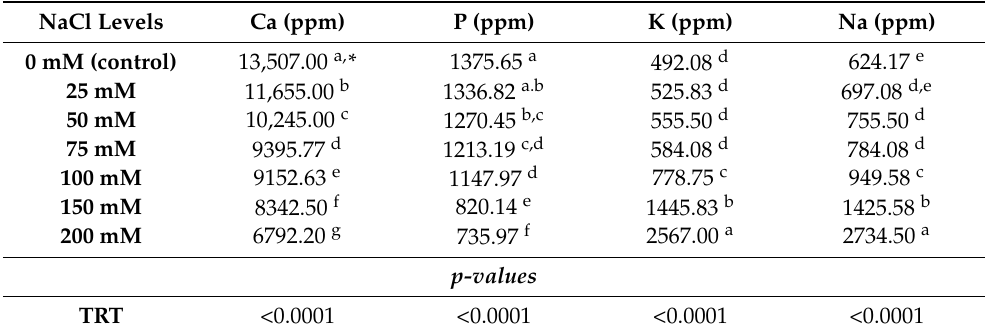
Table 5. Effect of different NaCl levels on Ca, P, K, and Na content for Q6 quinoa plantlets (dry weight basis).